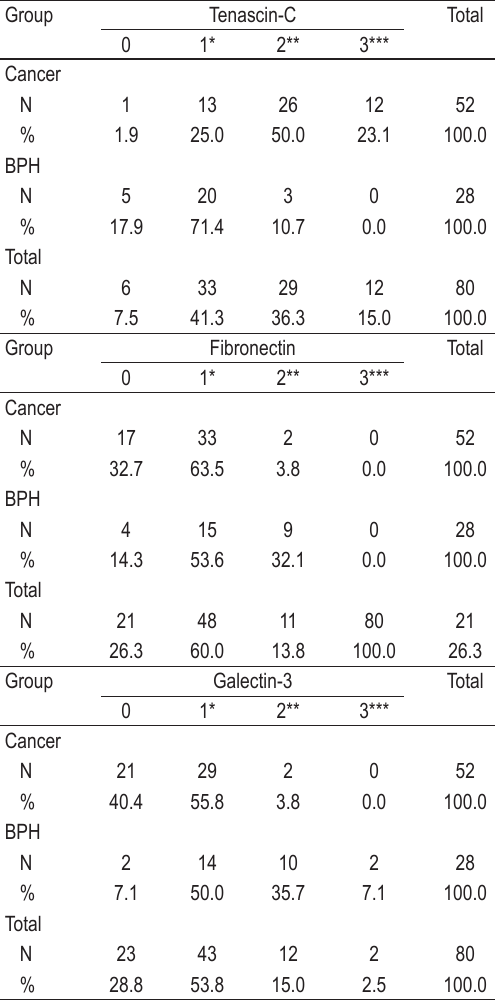
TABLE 3. Expression of tenascin‑C, fibronectin and galectin‑3 in tumoral and BPH